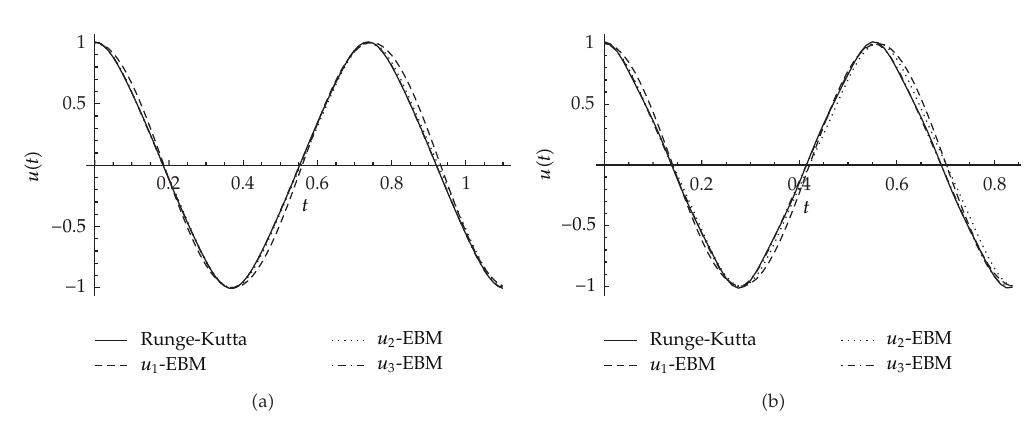
Figure 1: Approximate and numerical solutions for (cid:2) a (cid:3) A (cid:9) α (cid:9) 1, ε (cid:9) 100, λ (cid:9) 0; (cid:2) b (cid:3) A (cid:9) α (cid:9) 1, ε (cid:9) λ (cid:9)